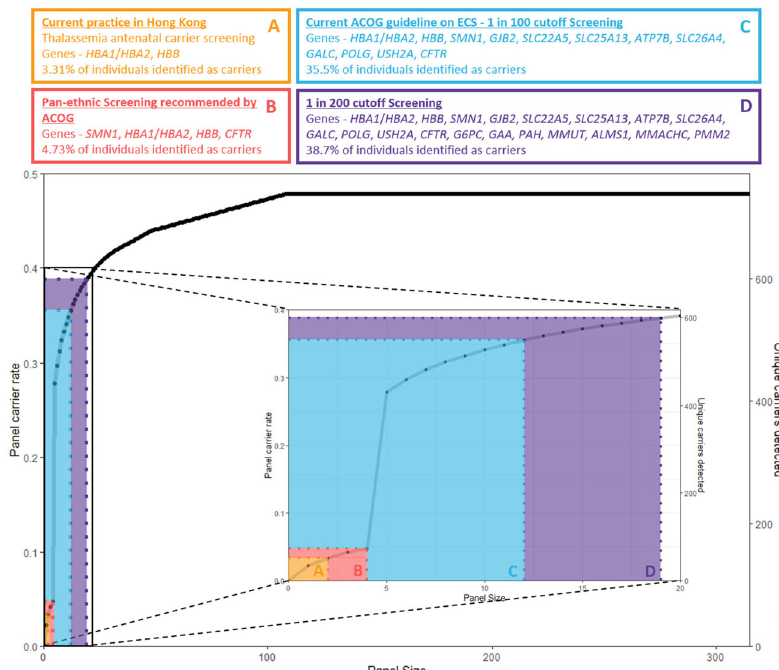
Fig. 1 Incremental detection of using ECS panel. The fi gure shows the incremental bene fi ts of using an ECS panel. The fi rst tier of carrier screening includes α -thalassaemia and β -thalassaemia with 3.31% of individuals identi fi ed as carriers. This is based on Hong Kong ’ s current antenatal screening guidelines. The second tier includes the pan-ethnic carrier screening disease conditions recommended by ACOG which accumulates spinal muscular atrophy and cystic fi brosis. Using these criteria, 4.73% of individuals were identi fi ed as carriers. The third tier is based on the 2017 ACOG guidelines on ECS with a cut-off of 1 in 100. Using these criteria, 35.5% of individuals were identi fi ed as carriers. Mutations in GJB2 were the most common, with a carrier rate of 24.5% in the Southern Chinese population (1 in 4 individuals). The fourth tier is a screening cut-off of 1 in 200, 38.7% of individuals were identi fi ed as carriers. Within this study, 47.8% of 1543 individuals were carriers of one or more recessive disease